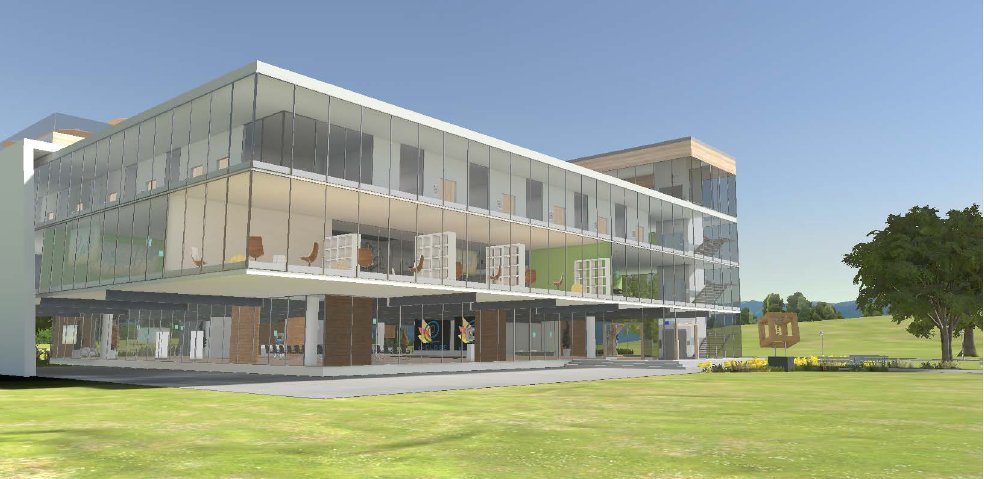
Figure 1. Virtual campus of the e-CLOSE project created in WBS LearnSpace